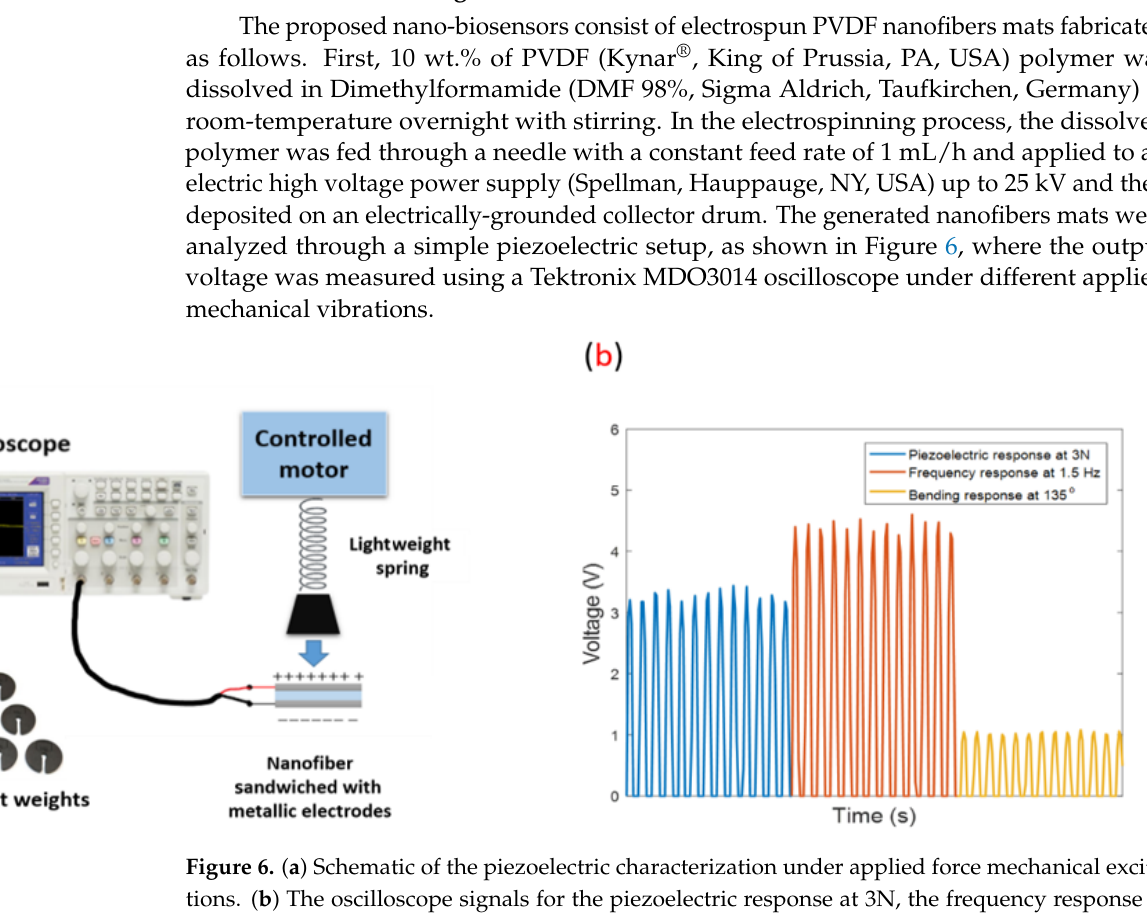
Figure 6. ( a ) Schematic of the piezoelectric characterization under applied force mechanical excita- tions. ( b ) The oscilloscope signals for the piezoelectric response at 3N, the frequency response at 1.5 Hz, and the bending response at 135°.